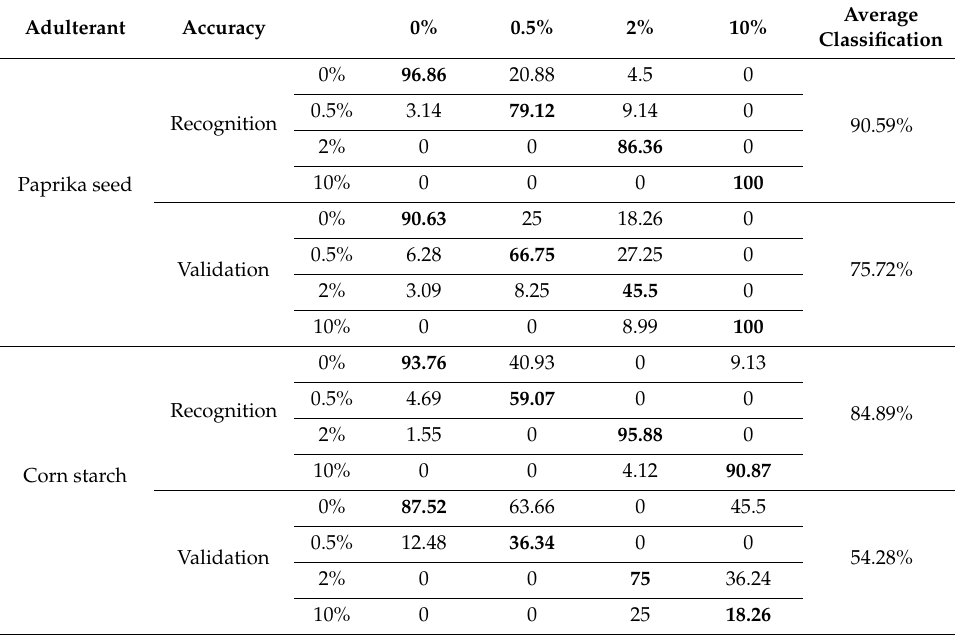
Table 10. LDA classifications after drift correction, outlier detection and three-fold cross-validation when the adulterant concentration was used as class variable on the e-tongue data of paprika seed—and starch—adulterated tomato pastes.